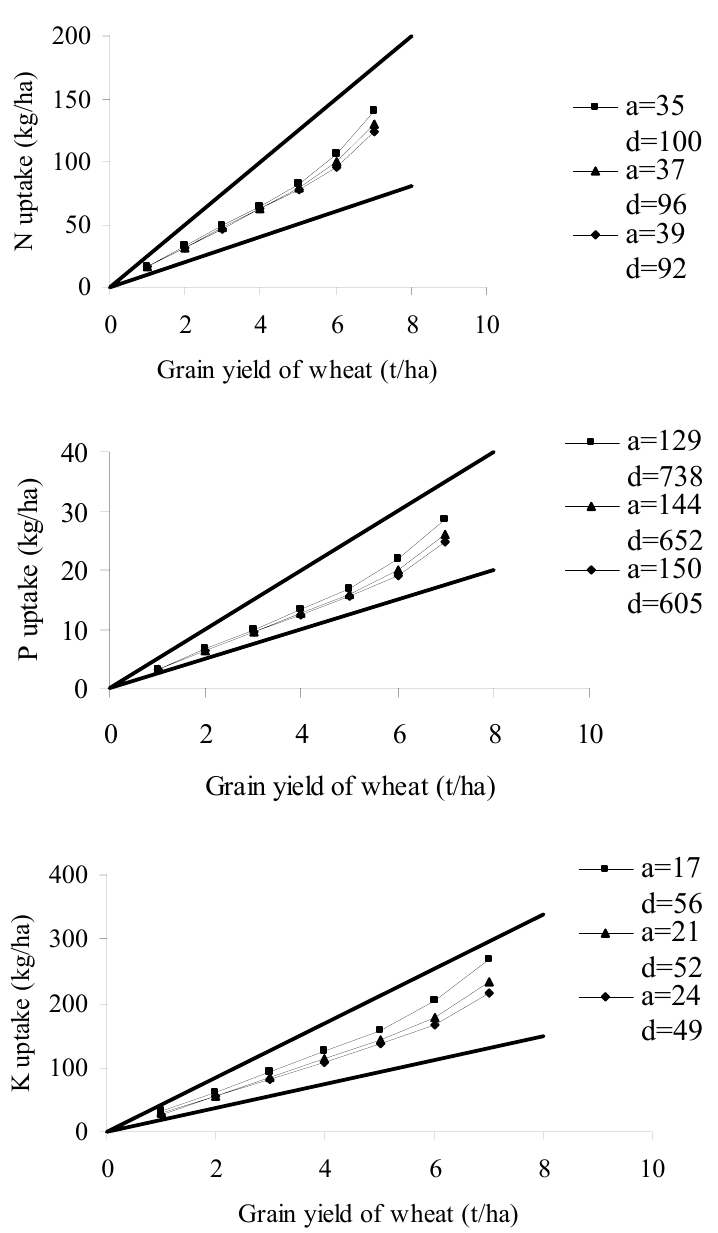
FIGURE 3. Yield of wheat in relation to plant nutrients at different sets of constants “a” and “d”, calculated by excluding the upper and lower 10 th (Set I), 15 th (Set II), and 20 th percentiles (Set III) of all internal efficiency data. The upper and lower lines indicate yields with maximum dilution and maximum nutrient accumulation,